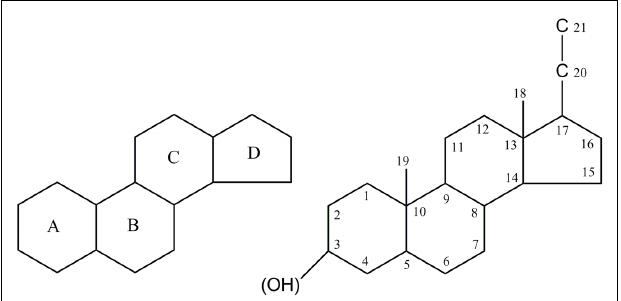
FIGURE 2 | Features of general structure of the neurosteroid. Figure shows intact four ring system that often contains hydroxyl side chains as sterols. Hydroxyl groups are denoted α if they are oriented above the plane (solid line), and α if they are oriented below the plane (dashed line). Stereoisomerism and structural modifications were discussed at carbon 3, 5, 6, 7, 17, 20, and 21 positions.